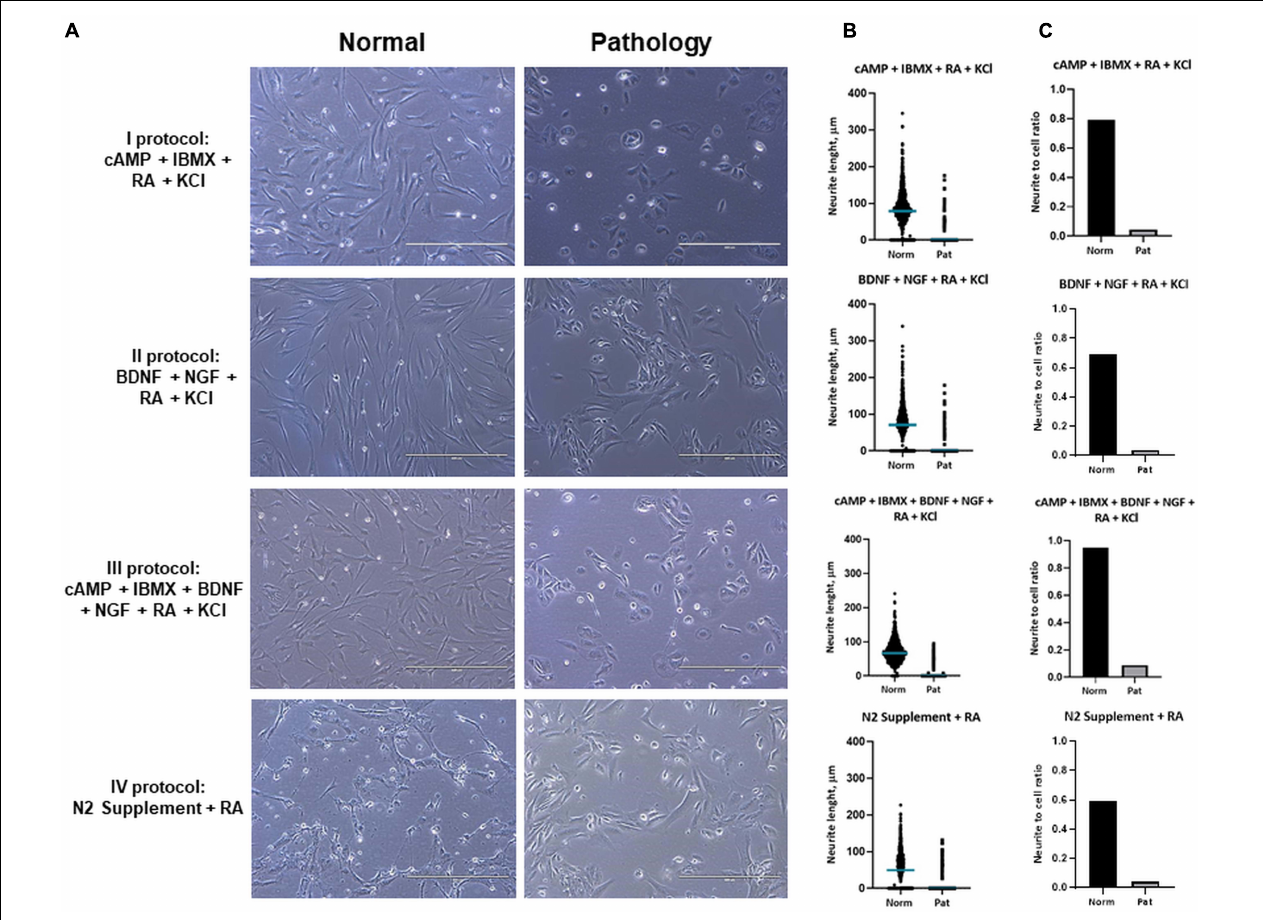
FIGURE 3 | Neuronal differentiation of hAFSCs from normal and fetus-affected gestations. (A) Representative images of hAFSCs from normal (Normal) and fetus-pathological (Pathology [Pat1]) gestations upon 72-h treatments with different neuronal differentiation inducing cell culture medias, denoted as I–IV protocols (see Table 1 in section “Materials and Methods”; scale bars = 400 µ m). (B) Neurite length ( µ m) estimation for neuro-differentiated hAFSCs, obtained from fetus-unaffected (Normal, n = 3) and fetus-affected (Pathology, n = 3) gestations was performed using ImageJ program with the NeuronJ plugin; all estimated values ( n > 1,000) were presented in scatter plot with median value denoted. (C) Neurite number per cell for neuro-differentiated hAFSCs, obtained from fetus-unaffected (Normal, n = 3) and fetus-affected (Pathology, n = 3) gestations was estimated and presented as neurite-to-cell ratio ( n > 1,000).